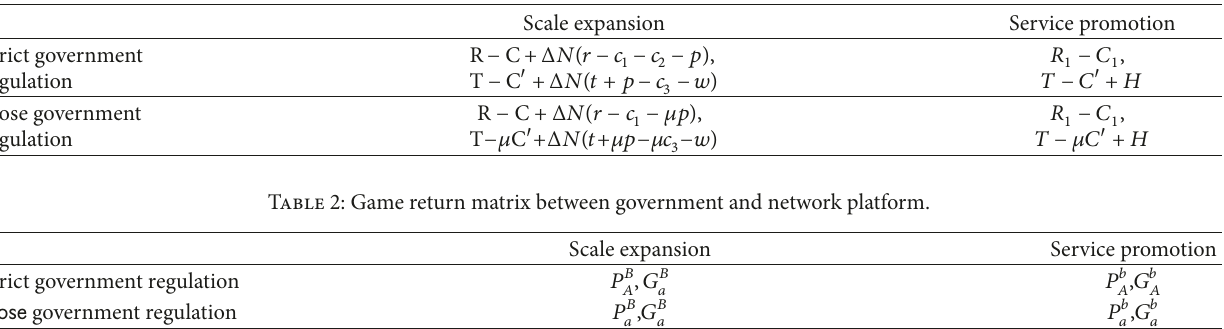
Table 1: Game return matrix between government and network platform.